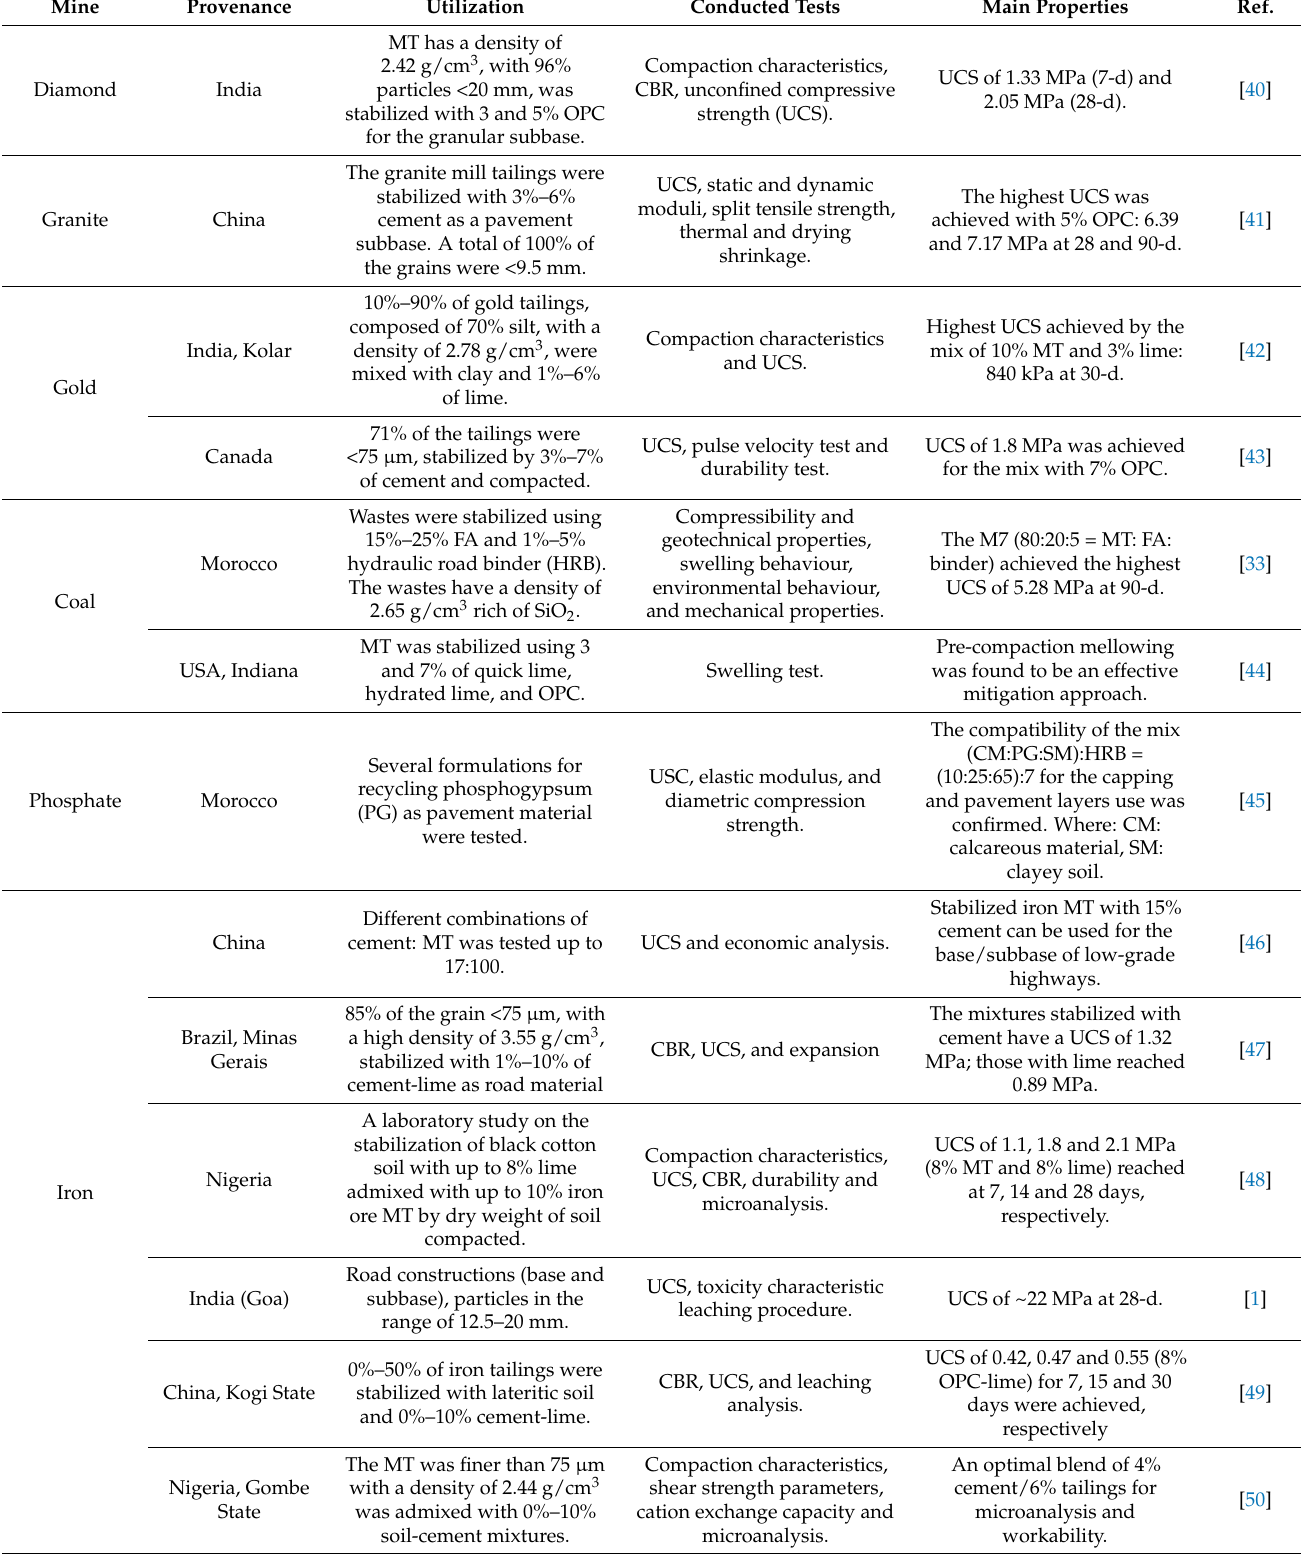
Table 3. Mine wastes used in road construction—treated with a hydraulic